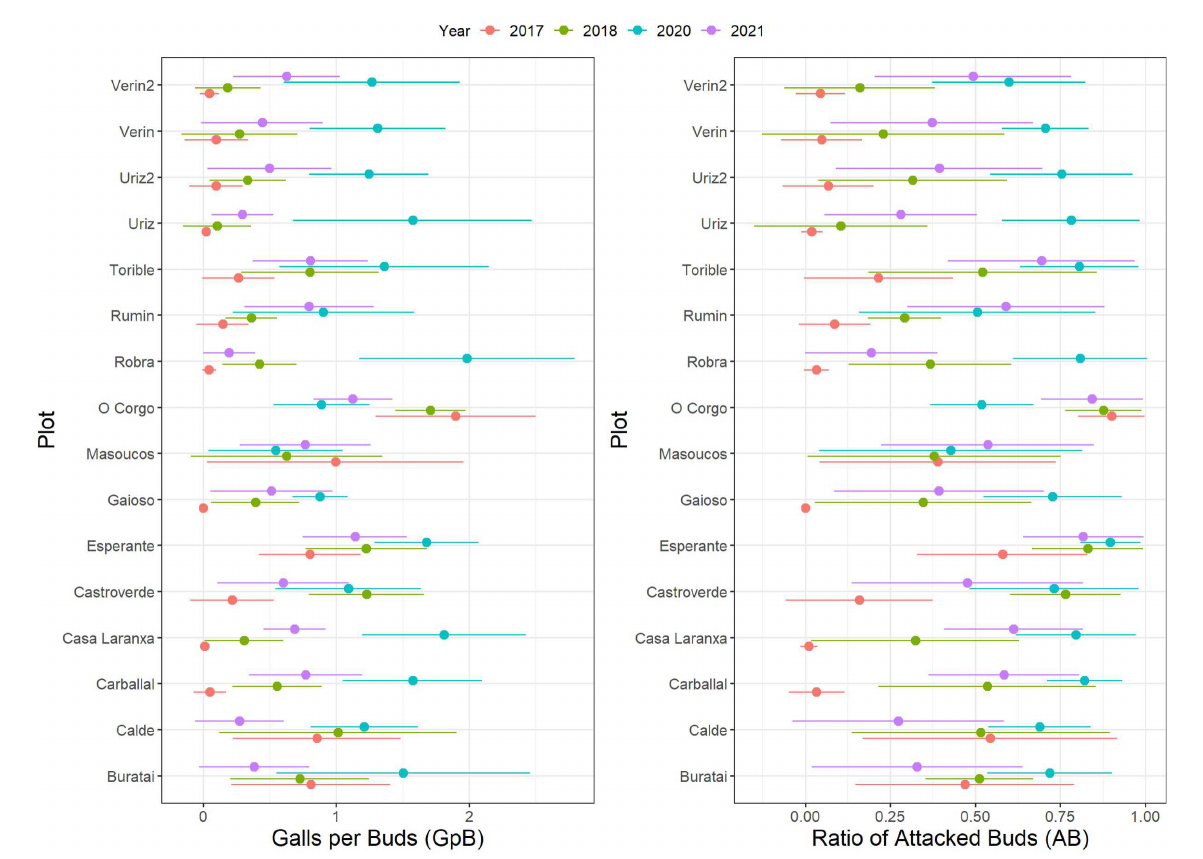
FIGURE2 Changes in GpB and AB infestation indices in the 16 study plots throughout the study period. Note that in the “Esperante” and “O Corgo” plots, the infestation level corresponds to hybrid clone trees susceptible to the gall wasp.